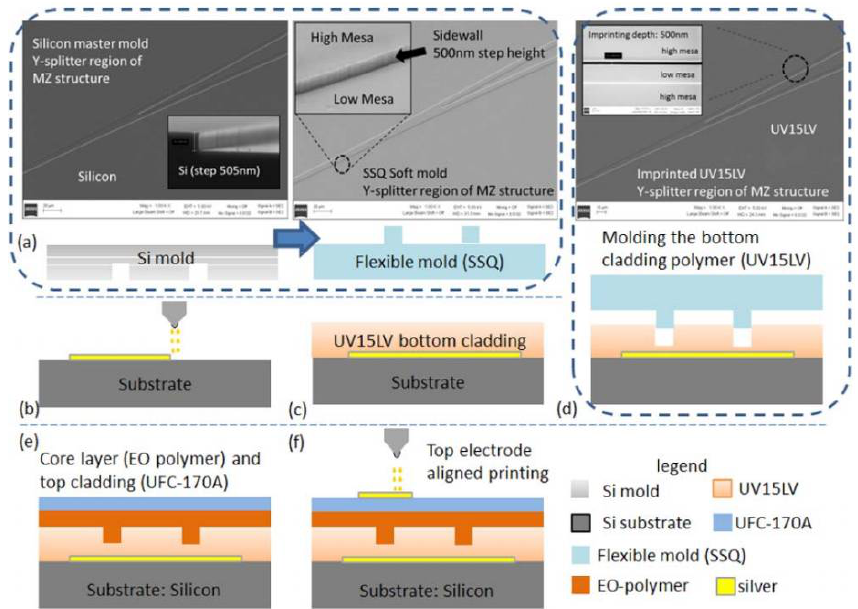
Figure 24. Main process flow for fabricating an EO polymer modulator using imprinting and ink-jet printing methods. ( a ) Silicon and SSQ mold; ( b ) bottom electrode deposition; ( c ) bottom cladding layer deposition; ( d ) imprinting; ( e ) core layer and top cladding layer deposition; and ( f ) top electrode deposition [80]. Copyright 2013 OSA. Polymers 2018 , 10 , x FOR PEER REVIEW